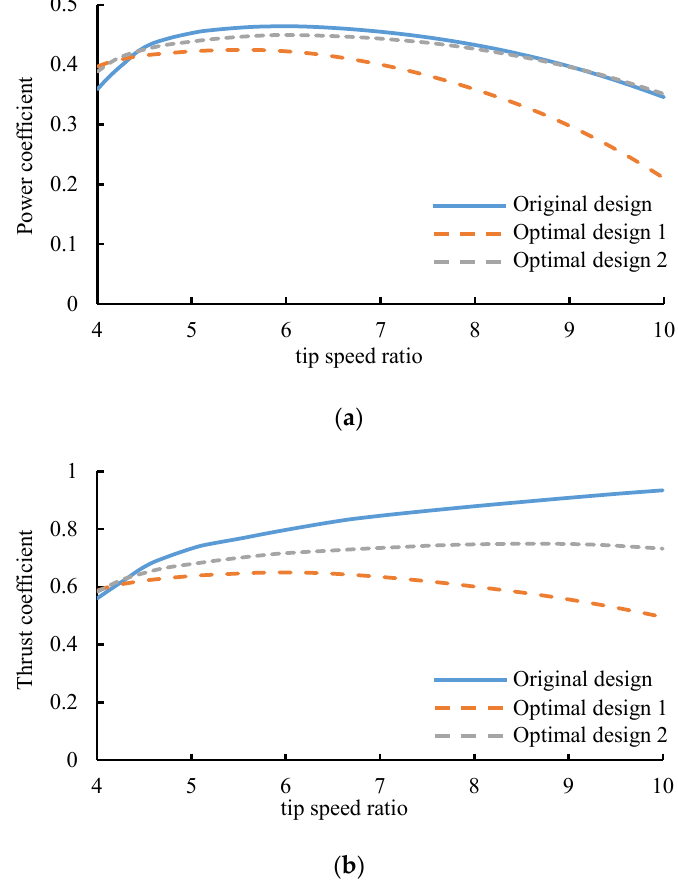
Figure 13. Performance coe ffi cients: ( a ) Power coe ffi cient; ( b ) Thrust coe ffi cient. Table 4. Comparison between the original and optimal designs.